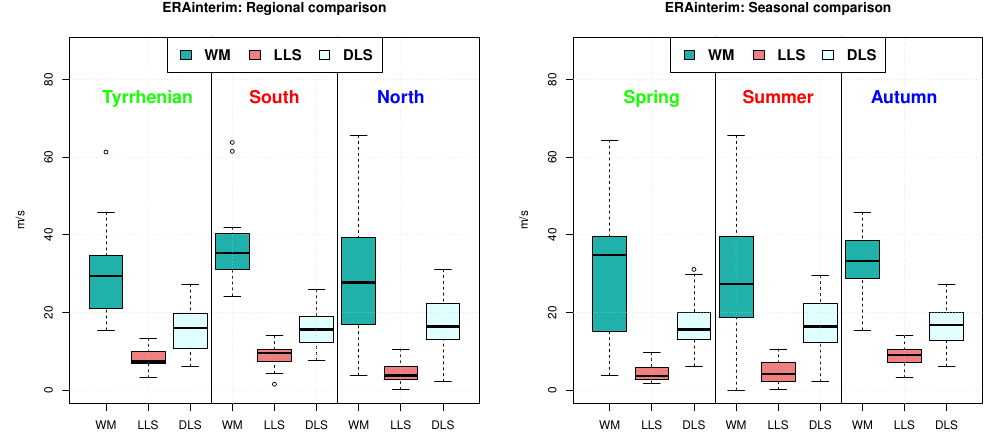
Figure A2. Same as Figure 3 but considering the ERA-Interim dataset.